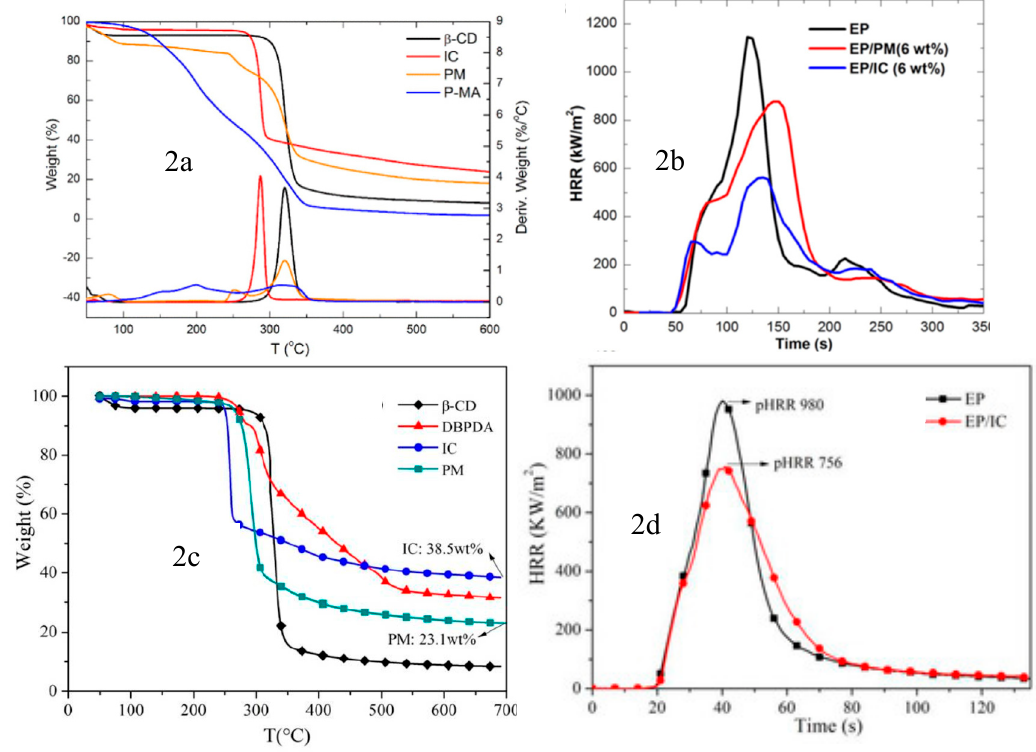
Figure 2. ( a ): TGA (Nitrogen flow, heating rate 10 ◦ C/min) of N,N (cid:48) -diamyl-p-phenylphosphonicdiamide (P-MA), BCD ( β -CD), inclusion complex BCD-P-MA (IC); physical mixture BCD-P-MA (PM). ( b ): HRR from cone calorimeter test of epoxy resins (EP), EP fire retarded with 6% of BCD-P-MA physical mixture (EP/PM) and EP fire retarded with 6% of BCD-P-MA Inclusion complex (EP/IC). Adapted with permission form ref. [53]. ( c ): TGA (Nitrogen flow, heating rate 10 ◦ C/min) of N,N’-dibutyl-phosphate diamide (DBPDA), BCD ( β -CD), inclusion complex BCD-DBDPA (IC); physical mixture BCD-DBDPA (PM). ( d ): heat release rate (HRR) from cone calorimeter test of EP and of EP fire retarded with BCD-DBDPA Inclusion complex. Adapted from ref. [54] open access.